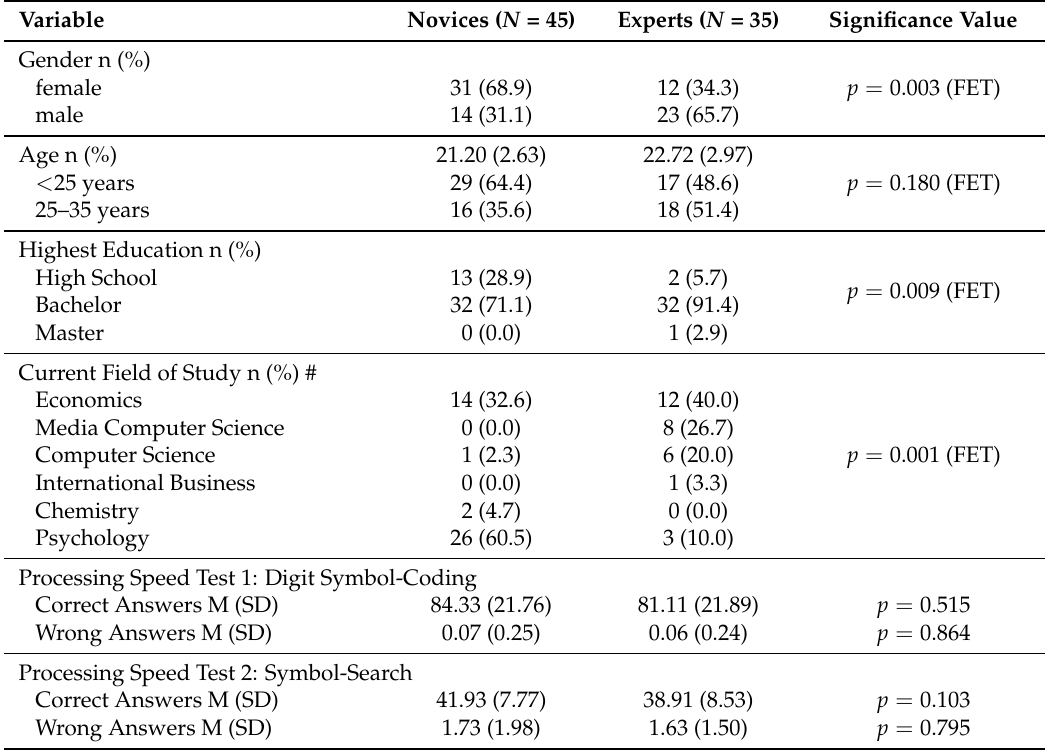
Table 3. Sample description and comparisons between novices and experts in baseline